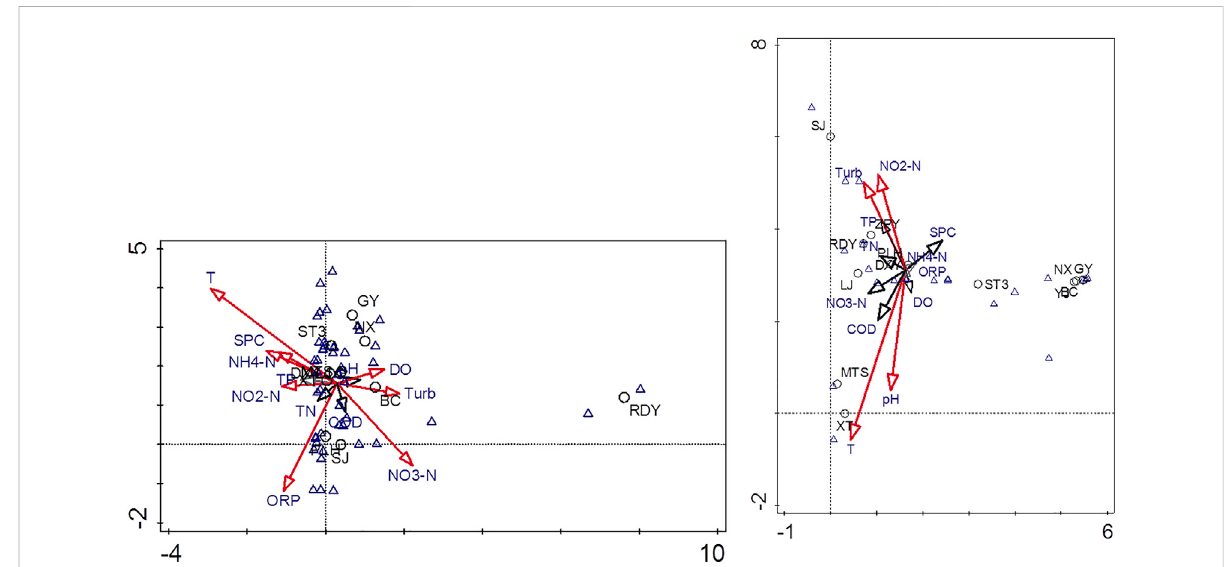
FIGURE 7 The ordination of DCA between environmental factors and plankton species (left: phytoplankton; right: zooplankton) in the Lijiang River watershed.